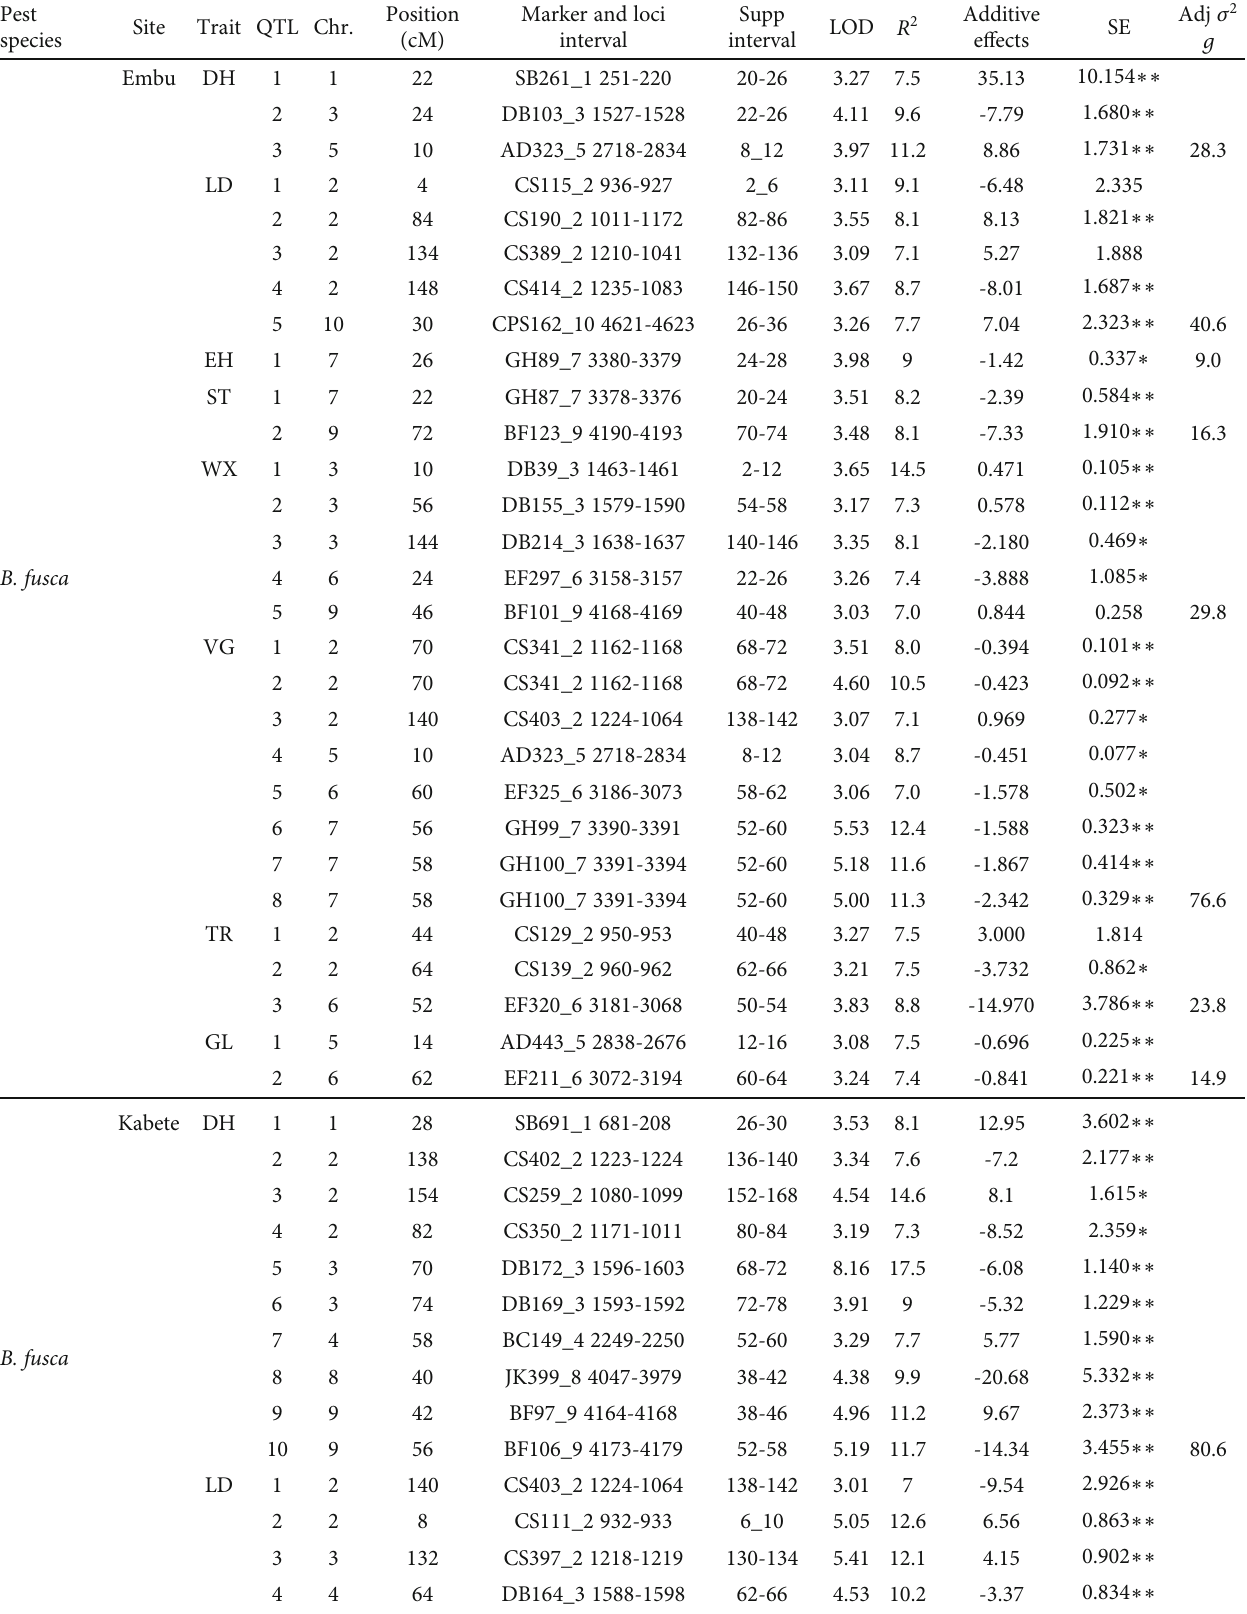
Table 12: QTL analyses at the three sites from the RIL sorghum population derived from ICSV745 × PB15520 ‐ 1 . Pest Site Trait QTL Chr. species